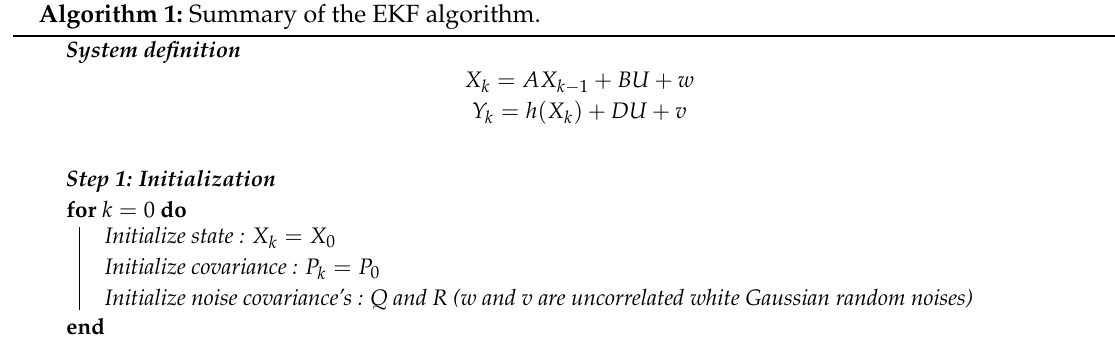
Algorithm 1 resumes the steps of the EKF used based basically on two major phases, the prediction based on previous states and the correction based on updating data by the measurement. Algorithm 1: Summary of the EKF